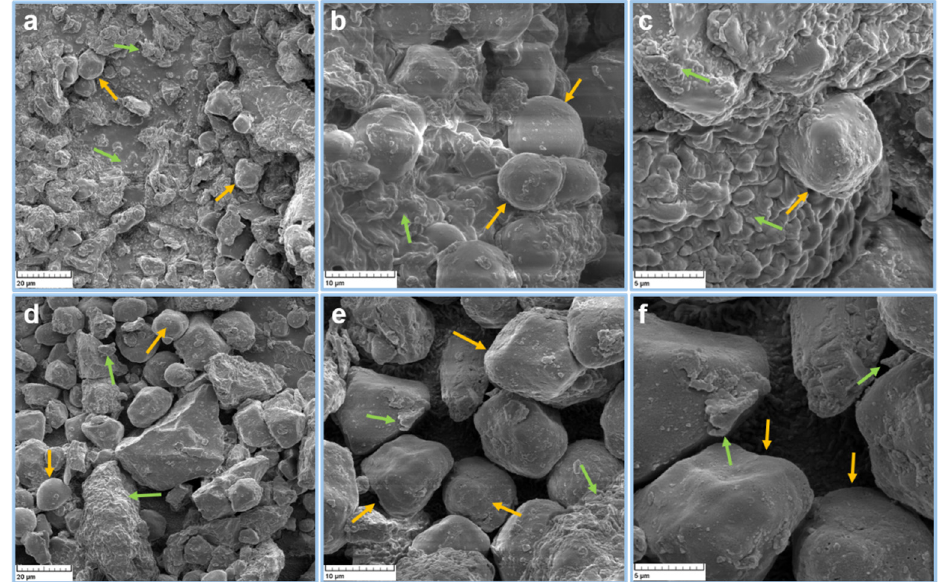
Figure 6. Scanning electron micrographs representing differences in the starch–protein matrix of fresh and ensiled high-moisture corn. The differences were examined on 1 mm ground corn samples using a scanning electron microscope operating at 5 kV under 2000×, 5000×, or 10,000× magnifica- tions. Scanning electron micrographs are as follows: fresh corn 2000× ( a ), fresh corn 5000× ( b ), fresh corn 10,000× ( c ), ensiled high-moisture corn 2000× ( d ), ensiled high-moisture corn 5000× ( e ) and en- siled high-moisture corn 10,000× ( f ). Starch granules in the ensiled samples ( d – f ) were more acces- sible due to the reduction of the zein protein layer surrounding the starch granules compared to the fresh corn samples ( a – c ). On scanning electron micrographs, examples of starch granules are marked with orange arrows and examples of zein protein coating/layer are marked with green ar- rows. Ruminal degradability is defined by the first-order kinetics equation, the so-called McDonald model [28], which usually neglects the influence of the lag phase by assuming immediate substrate hydration and colonization by microorganisms [44]. However, Dhanoa [29] showed that the simultaneous estimation of the lag phase parameter within the McDonald model is beneficial for the adequate evaluation of the kinetic parameters. In this study, the ensiling affected the lag phase of both starch and DM degradability; the reduction in their duration was consistent with the proposed influence of zein on starch availability. The high-moisture corn silages ensiled with Lactiplantibacillus plantarum and lactic acid that exhibited a more intense γ -zein reduction also had shorter lag phases. The